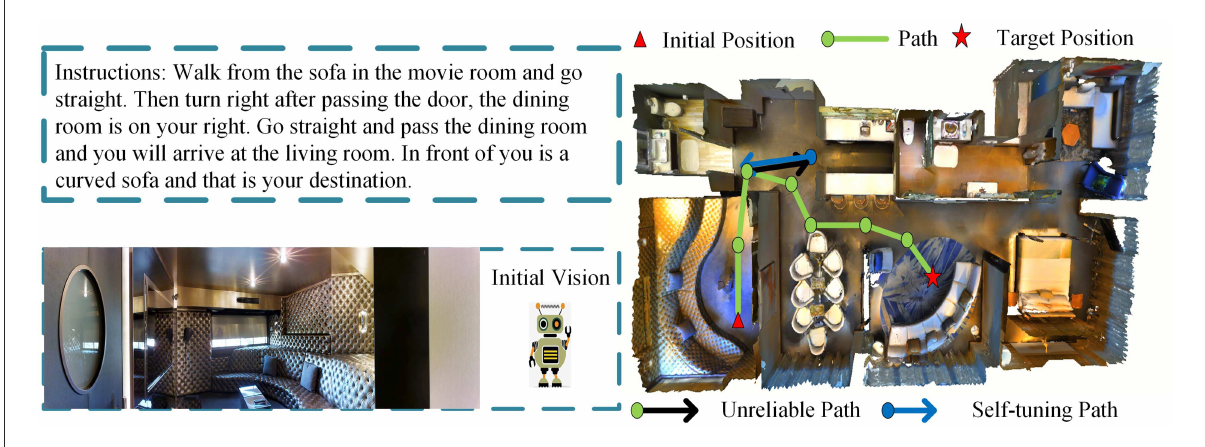
FIGURE1 Examples of vision and language navigation (VLN) tasks are executed by VIM